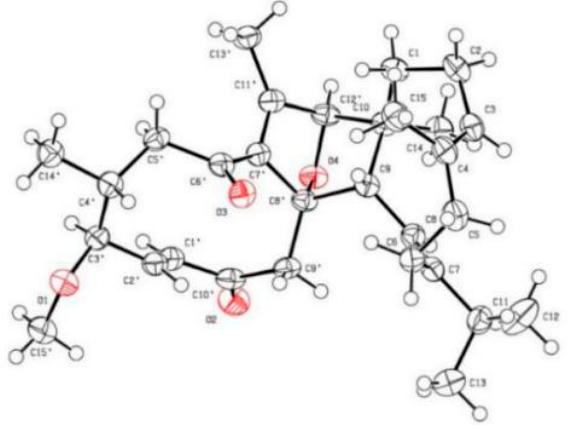
Figure 3. X-ray crystallographic structure of 1 .